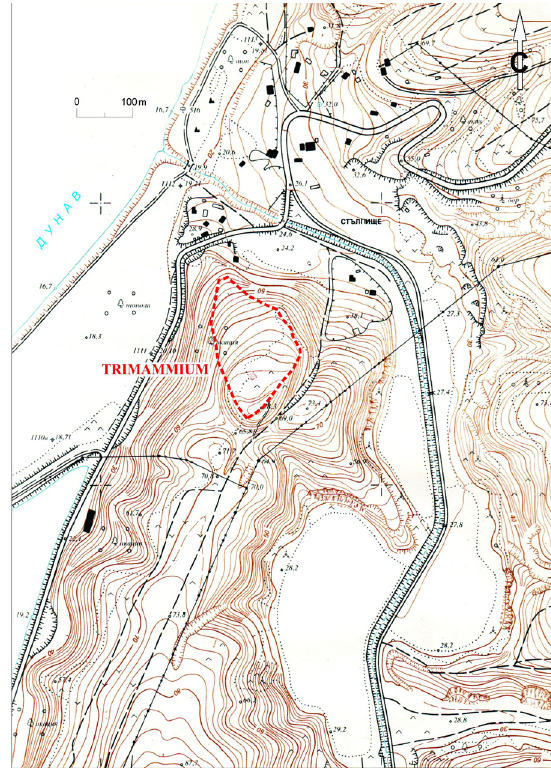
Figure 1. Map of the area of Trimammium .